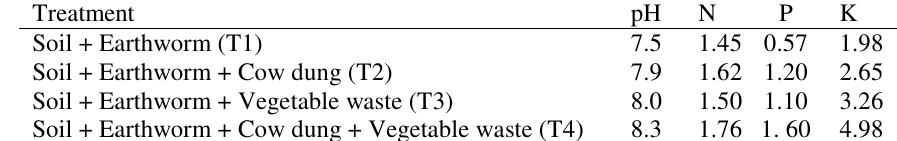
Table 1. Nutrient values of vermicompost (values are given in percentage). Treatment